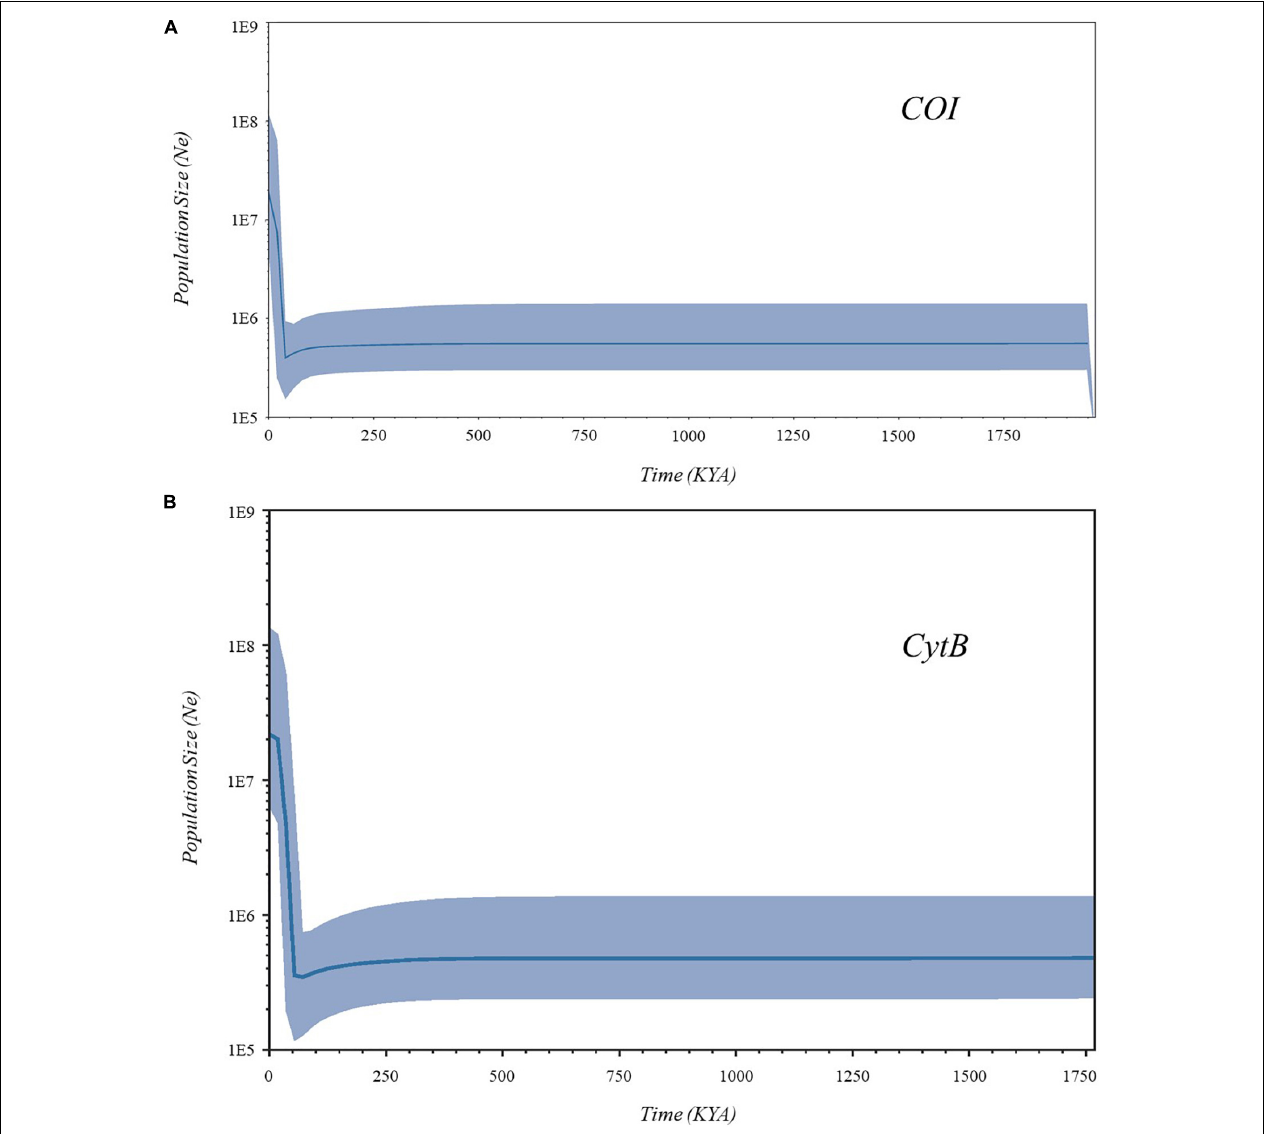
FIGURE 5 | Bayesian skyline plot based on (A) cytochrome oxidase I (COI) and (B) cytochrome B (CytB) for the effective population size changes throughout time. X -axes represent time in thousand years ago (KYA), while Y -axes show the effective population size ( N e ). The blue line represents the median, while the thick blue band represents 95% highest posterior density (HPD)